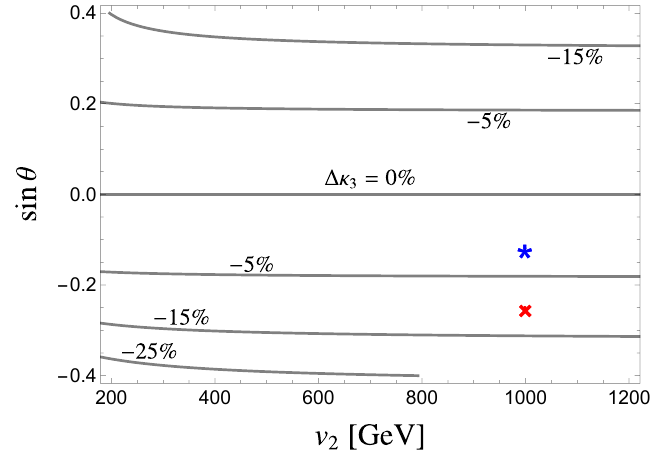
Figure 3. Predicted deviation of ∆ κ 3 in the v 2 - sin θ plane as defined in eq. (3.28). The red-cross and blue-star indicate the predictions for our BM1 and BM2 points,